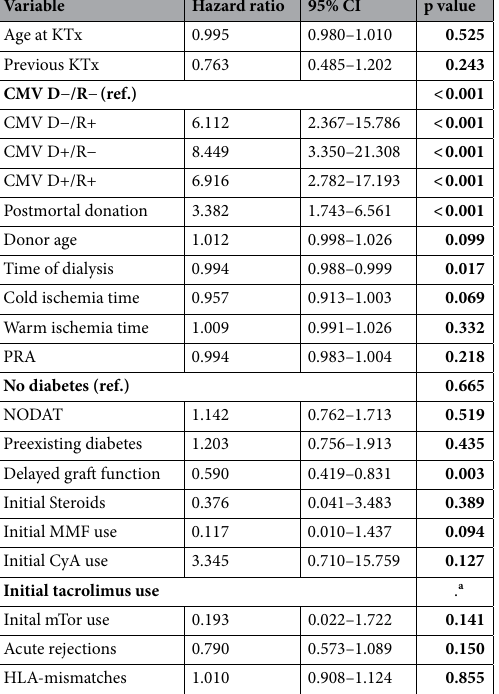
Table 3. Cox regression for CMV DNAemia risk factors. KTx kidney transplantation, CMV cytomegalovirus, D/R donor/recipient, PRA panel reactive antibodies, NODAT New onset diabetes after transplantation,